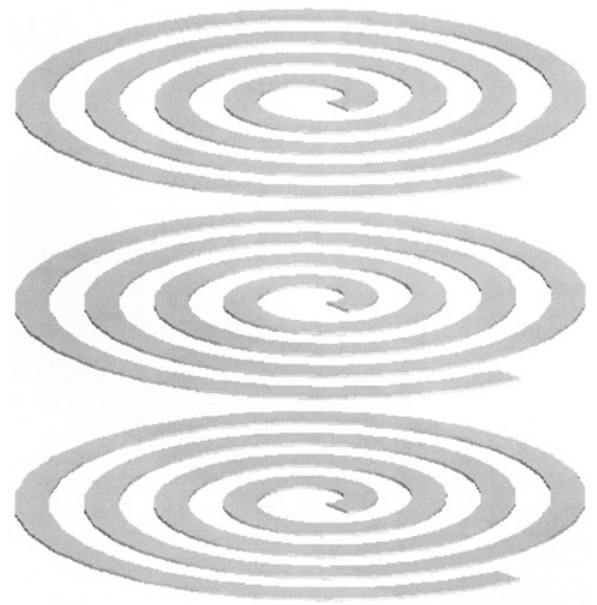
FIGURE 4 Schematic drawing of the multi layer